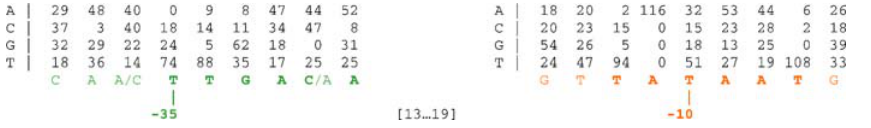
Figure 2. Frequency Matrices for the (cid:1) 10 and (cid:1) 35 Motifs of r 70 Promoters in E. coli This matrix pair (Matrix_18_15_13_2_1.5) was selected for searching across bacterial genomes from a collection of optimized matrices defined for E. coli in [1]. Note that in order to compare these matrices with the canonical patterns (TTGACA and TATAAT), the spacers of 13 bp to 19 bp between the two boxes correspond to the 15 bp to 21 bp reported in the literature, as the TGT triplet is considered as part of the (cid:1) 10 box. Before searching for promoter- like signals, these matrices were calibrated using the noncoding base composition of each target genome.